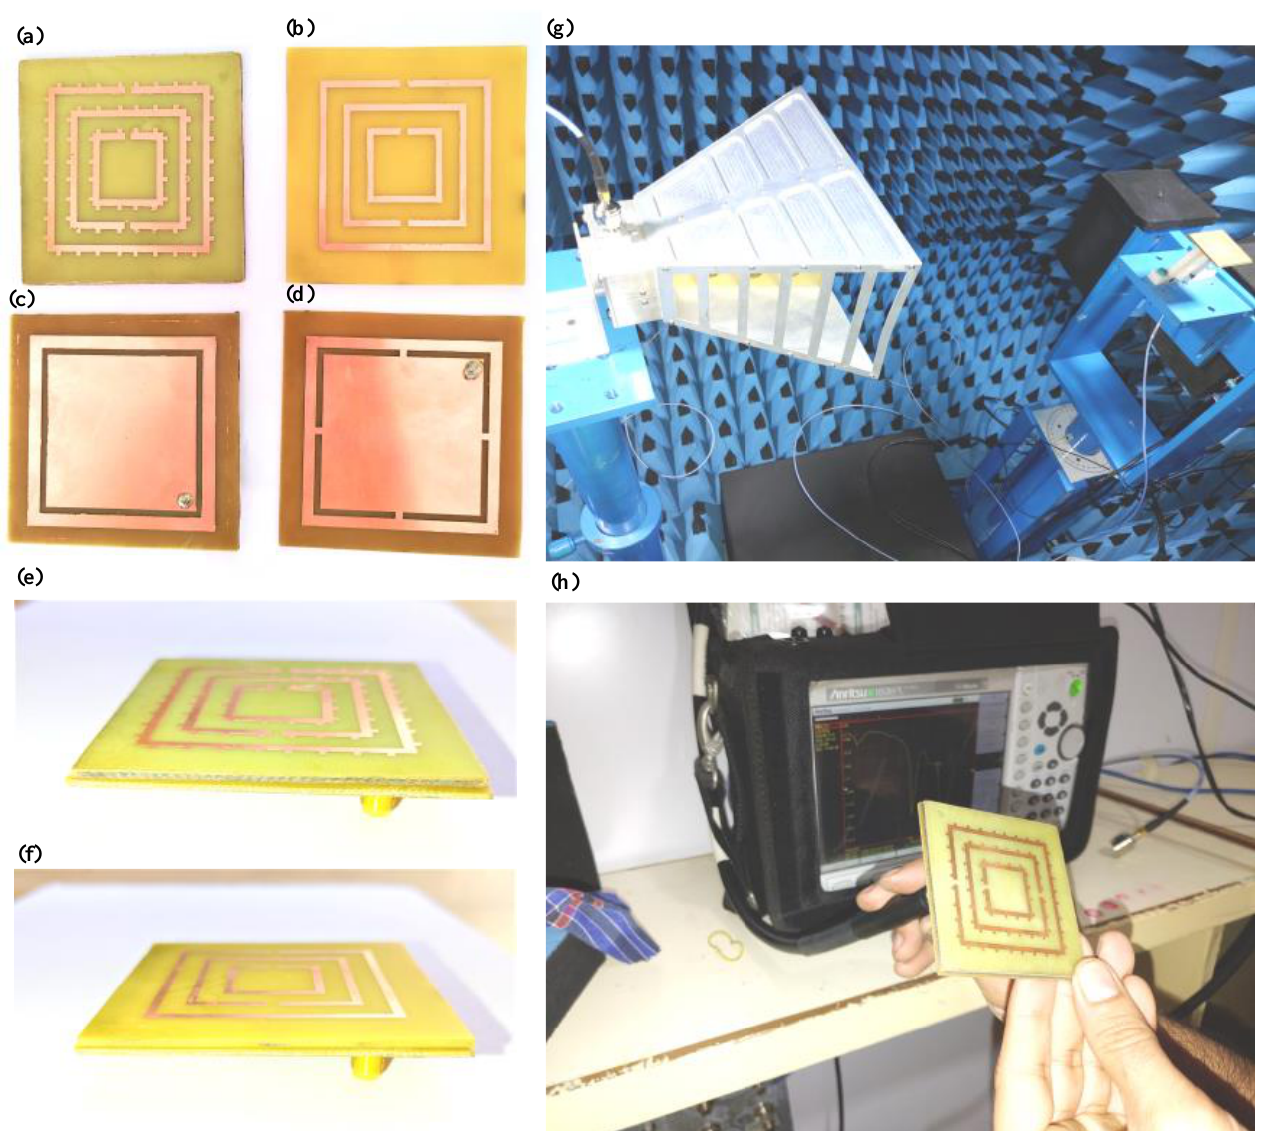
Figure 2. ( a – f ) The fabricated prototype of the proposed antenna structure. ( e ) Directivity measure- ment using the anechoic chamber. ( f ) Reflectance response measurement using a vector network analyzer.(g) Testing of antenna in Anachoic chamber. (h) Measuring reflectance response using Vec- tor Network Analyser.